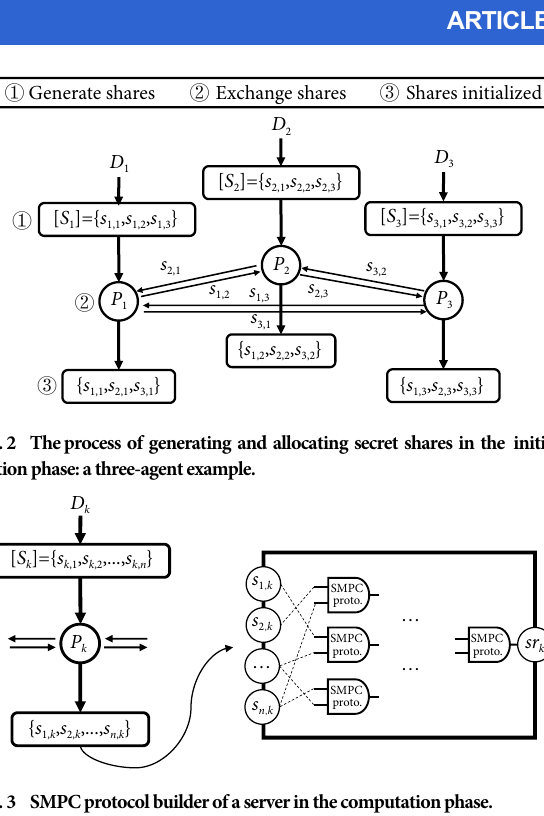
Fig. 3 SMPC protocol builder of a server in the computation